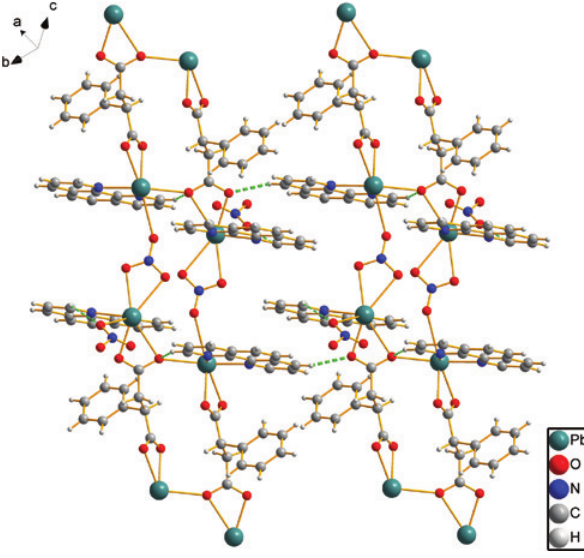
Figure 2: Supramolecular structure of the CP with the hydrogen bonds indicated as green dashed lines.